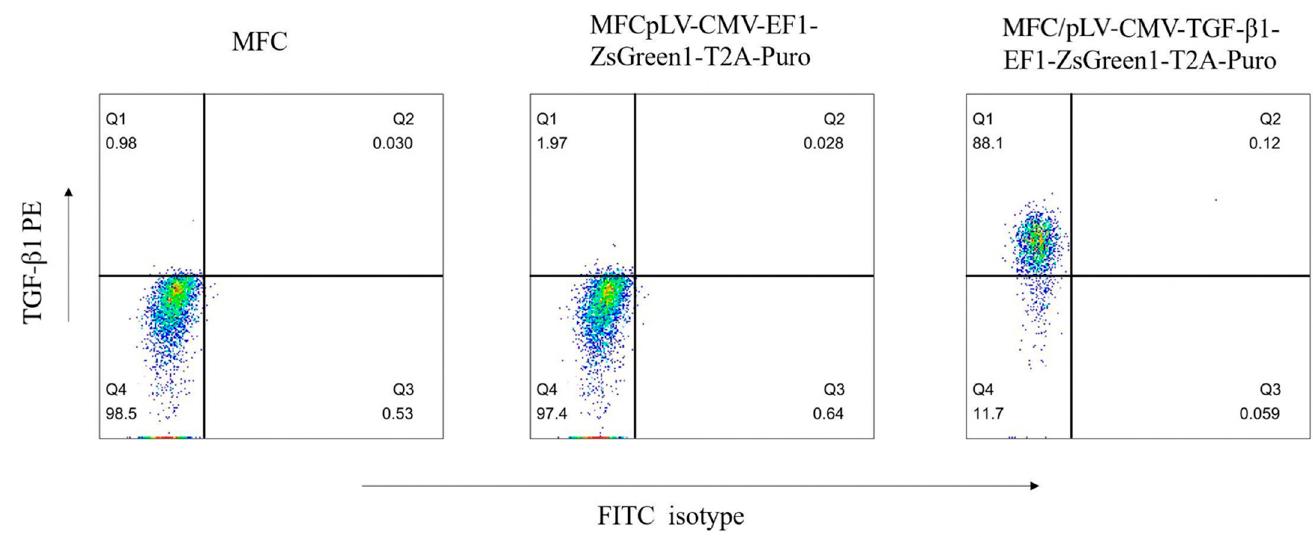
Figure 3. Flow cytometry analysis of TGF- β 1 expression in parental and transduced cells. Cells (1 × 10 6 ) were incubated with PE-anti-mouse TGF- β 1 for 30 min, and then analyzed by flow cytometry with the Expo32 ADC software. TGF- β 1 was expressed in >88% MFC/TGF- β 1 cells, while little expression was found in other cells.